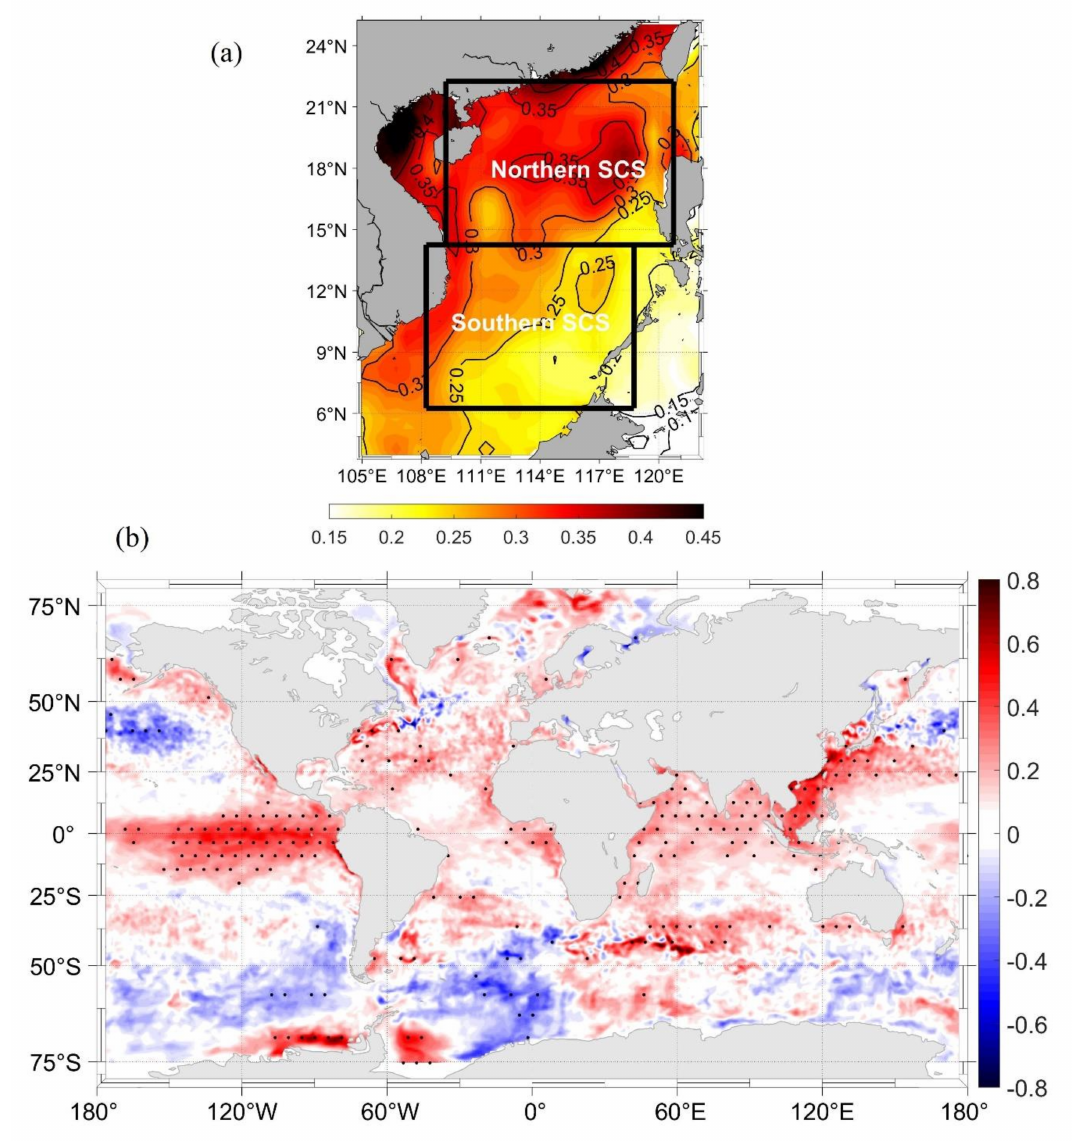
Figure 2. ( a ) The spatial patterns of the first empirical orthogonal function (EOF) mode of the boreal spring (from March to April) mean sea surface temperature (SST) anomalies (in ◦ C) over SCS. ( b ) Regression maps of global SST in boreal winter during the period 1958–2010 onto the normalized PC1. Areas exceeding the 95% significance level are stippled with little black